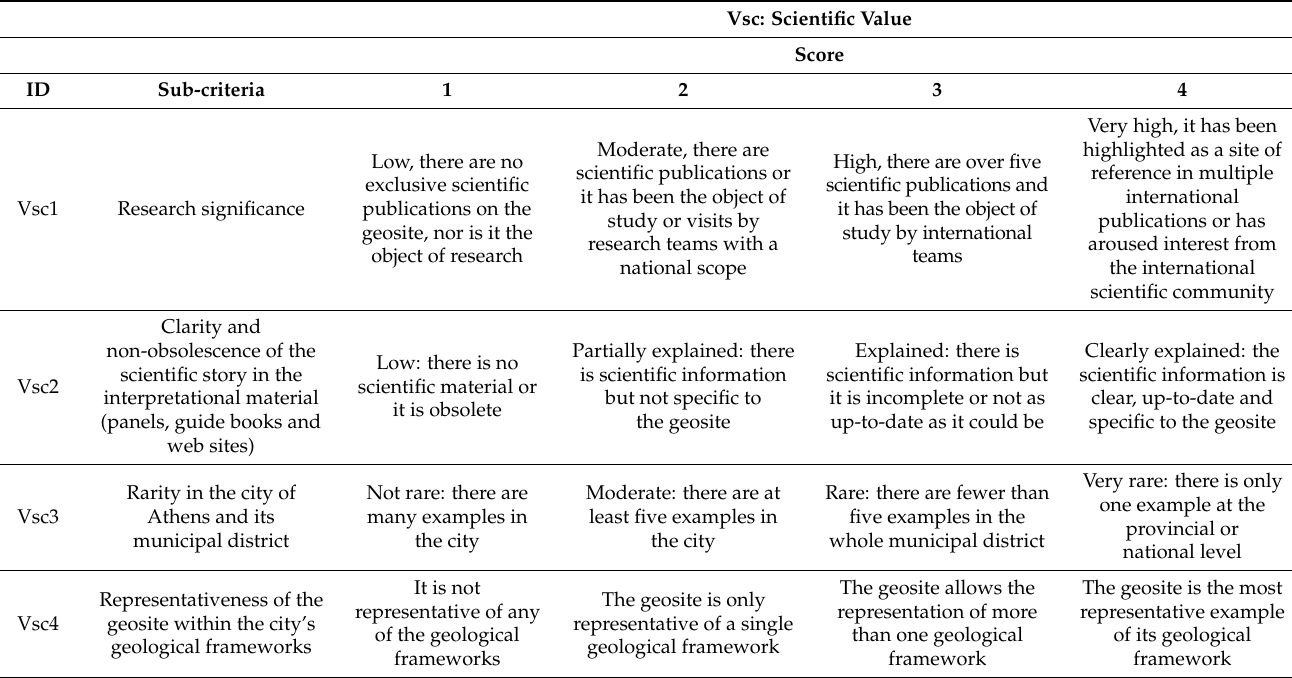
Table 2. Scientific value and sub-criteria [64,65].